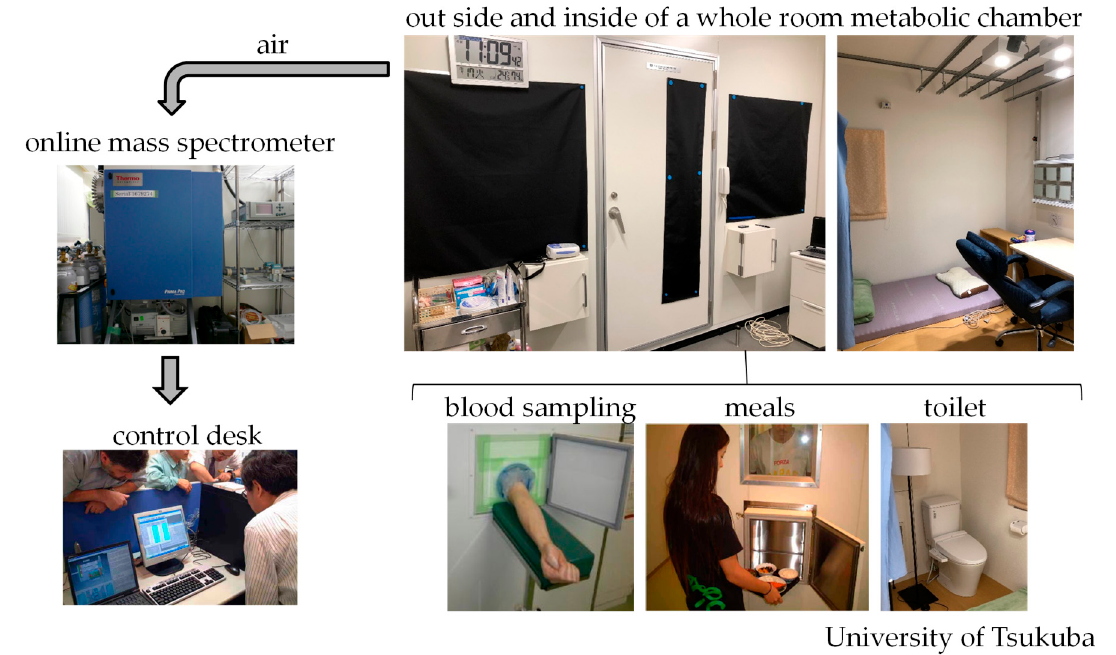
Figure 3. Whole-body indirect human calorimeter. A metabolic chamber for the measurement of substrate oxidation and energy expenditure over prolonged periods. In the airtight metabolic chamber (2.00 × 3.45 × 2.10 m; FHC-15S, Fuji Medical Science Co., Ltd., Chiba, Japan), air in the chamber was pumped out at a rate of 80 L/min. The temperature and relative humidity of the incoming fresh air was maintained at 25 °C and 55%, respectively. The chamber was furnished with an adjustable hospital bed, desk, chair, and toilet. Blood sampling and meal provision through the pass-box did not affect the measurements. The concentrations of oxygen (O 2 ) and carbon dioxide (CO 2 ) in the outgoing air were measured with high precision by online process mass spectrometry (VG Prima PRO; Thermo Fisher Scientific, Winsford, UK). The precision of mass spectrometry, defined as the standard deviation of the continuous measurement of the calibrated gas mixture (O 2 , 15%; CO 2 , 5%), was <0.002% for O 2 and CO 2 [52]. O 2 consumption (VO 2 ) and CO 2 production (VCO 2 ) rates were calculated each minute, using an algorithm for improved transient response [53].